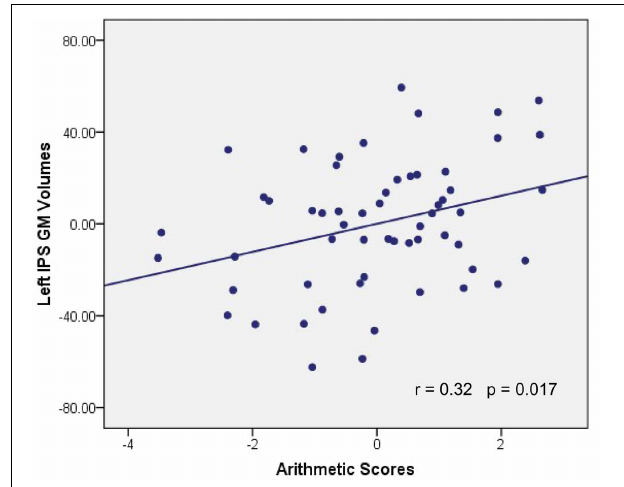
FIGURE 2 | Association between GM volume and WISC-RC arithmetic scores. Parietal residual plot with trend lines depicting the correlation between residuals in multiple regression analysis investigating the association between the GM volume in the left IPS and the WISC-RC arithmetic scores for entire cohort, after correction of full-scale IQ, age and gender. r denotes the partial correlation coefficient.